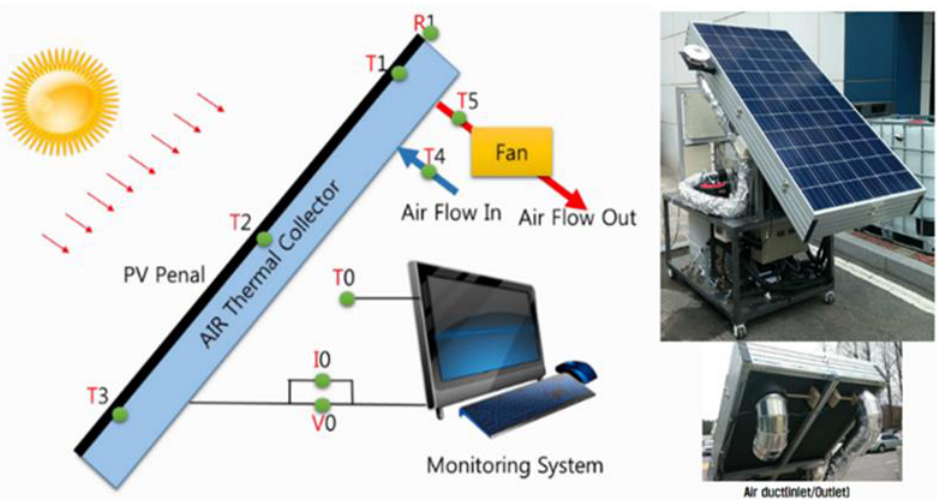
Table 1. PVT air material information. Figure 1. Photovoltaic-Thermal (PVT) performance test schematic diagram. Figure 1. Photovoltaic-Thermal (PVT) performance test schematic diagram.